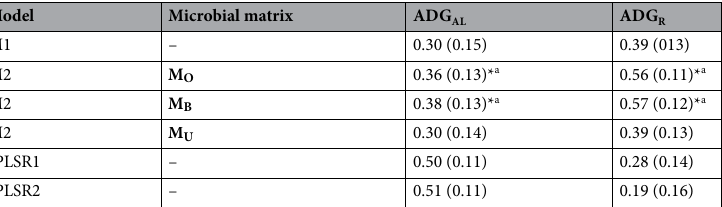
Table 4. Across 100 replicates average (SD) correlation coefficient between observed and predicted ADG AL and ADG R records with sPLSR and mixed models using the mDataset. ADG AL , average daily gain in rabbits fed ad libitum; ADG R , average daily gain in rabbits fed under restriction; SD, standard deviation; M1, mixed model without microbial effects; M2, mixed model fitting the microbial effects; M O , microbial relationship covariance matrix defined from CSS normalized OTU counts, M B , microbial relationship covariance matrix defined from Bray–Curtis distance matrix; M U , microbial relationship covariance matrix defined from weighted Unifrac distance matrix; sPLS1, sparse Partial Least Squares Regression model with systematic effects as predictors; sPLS2, sparse Partial Least Squares Regression model with systematic effects and CSS OTU counts as predictors. *M2 or sPLSR2 correlation between observed and predicted records significantly higher (bootstrapped paired t test) than M1 or sPLSR1 correlation after Bonferroni correction for multiple testing at the P < 0.05 level. a M2 or sPLSR2 correlation between observed and predicted records higher than M1